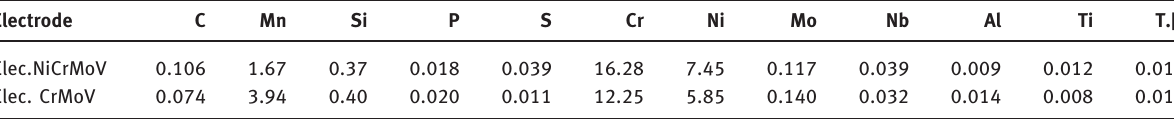
Table 1: Chemical composition of consumable electrode used in present experiment (wt.%).